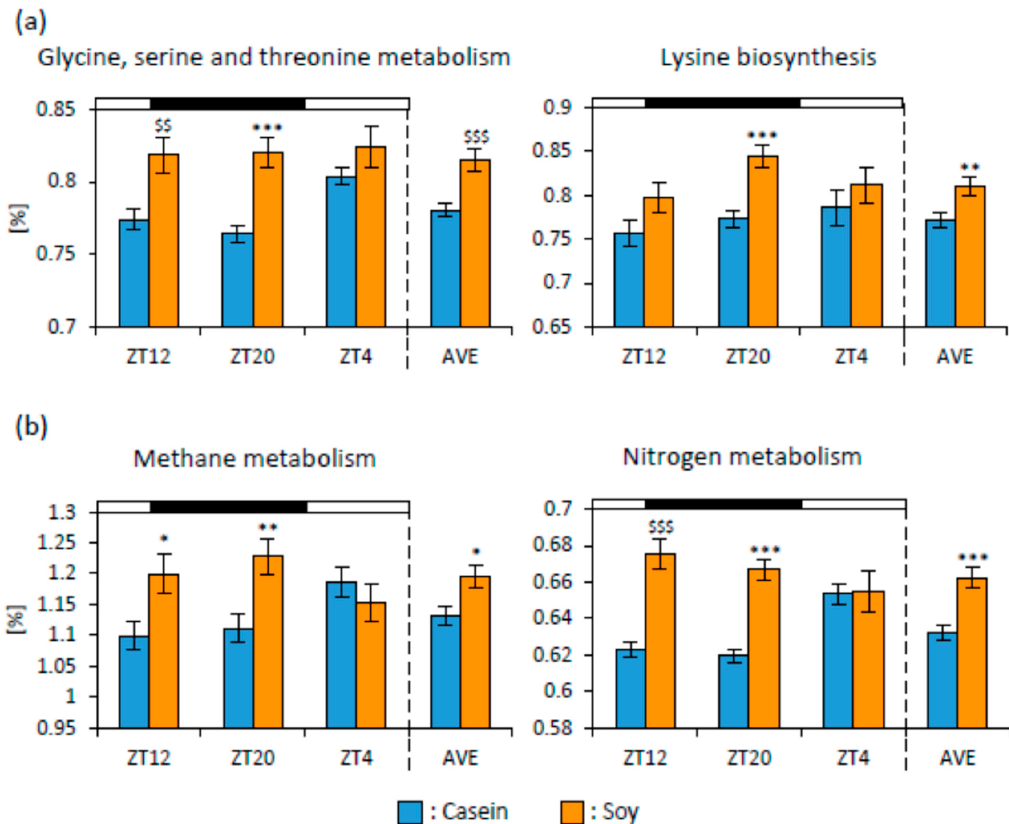
Figure 5. The functional predictions of microbial communities. ( a ) The functional predictions about categories related to “Amino Acid Metabolism” and ( b ) “Energy Metabolism” of microbial communities in mice that were fed each diet for 10 days (ZT12, ZT20, ZT4, and an average of three points). Data are represented as mean ± SEM ( n = 10). * p < 0.05, ** p < 0.01, *** p < 0.001 versus Casein, evaluated using Student’s t -test. $$ p < 0.01, $$$ p < 0.001 versus Casein, evaluated using the Mann-Whitney test.